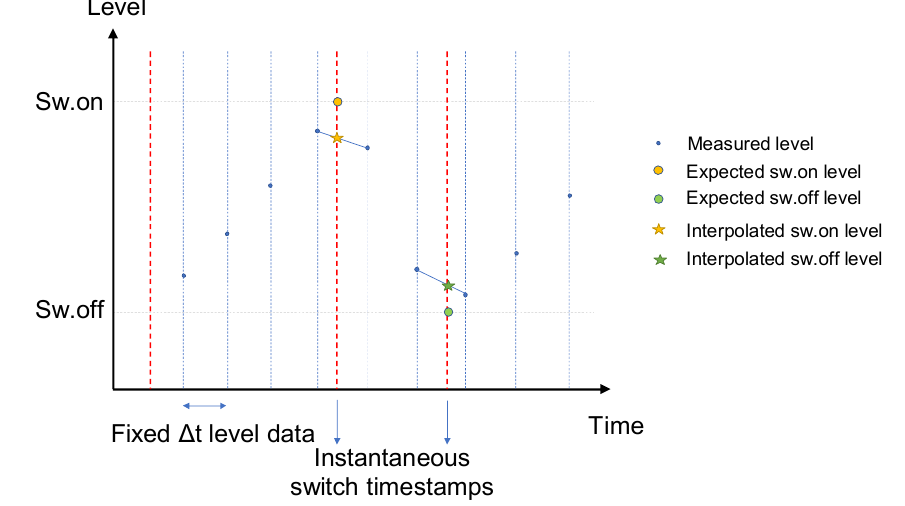
Figure A1. Estimation of switch levels by linear interpolation.